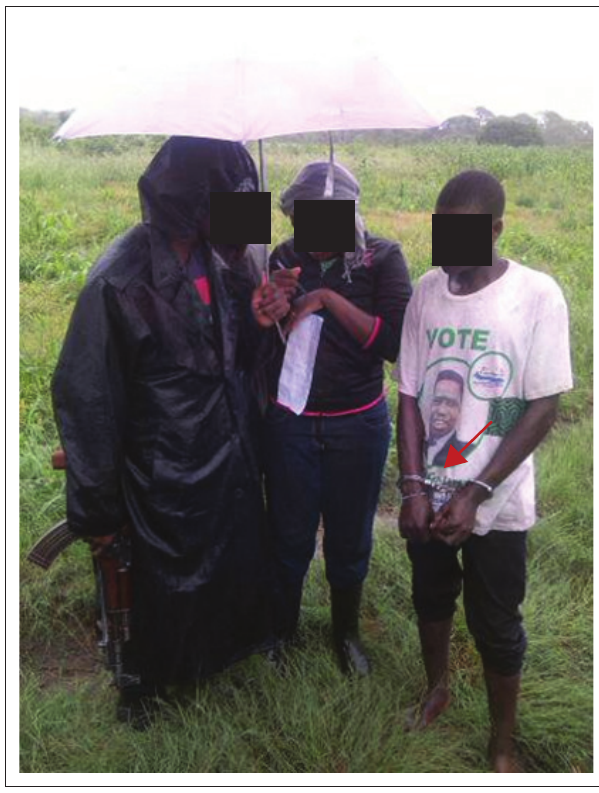
FIGURE 2: Cattle owner handcuffed by police officer to allow for cattle